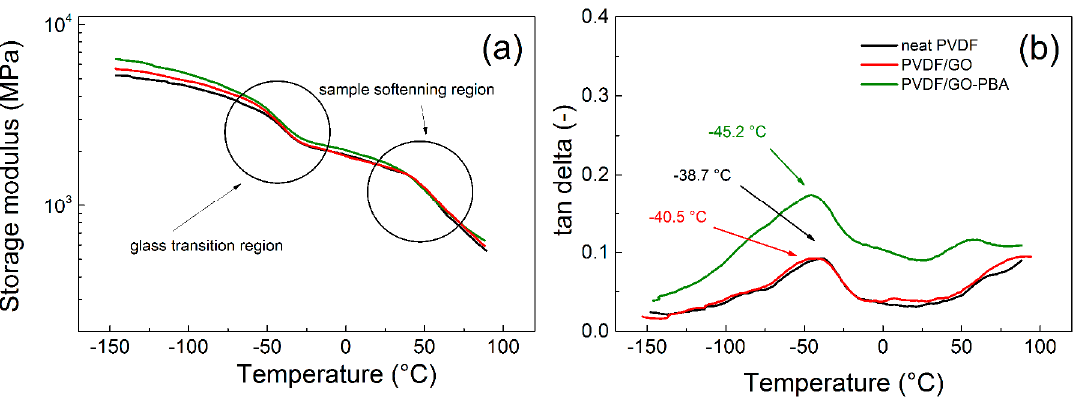
Figure 10. Temperature dependence of storage modulus ( a ) and tan delta ( b ) for neat PVDF and composites containing PVDF-GO and PVDF-GO-PBA particles,